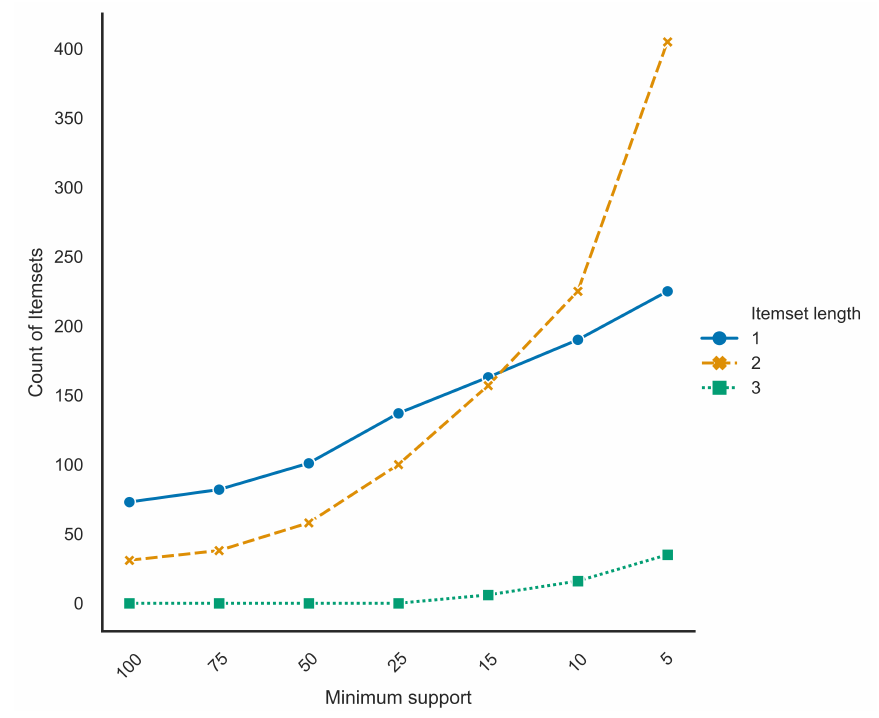
Figure 3. Counts of frequent itemsets by length and minimum